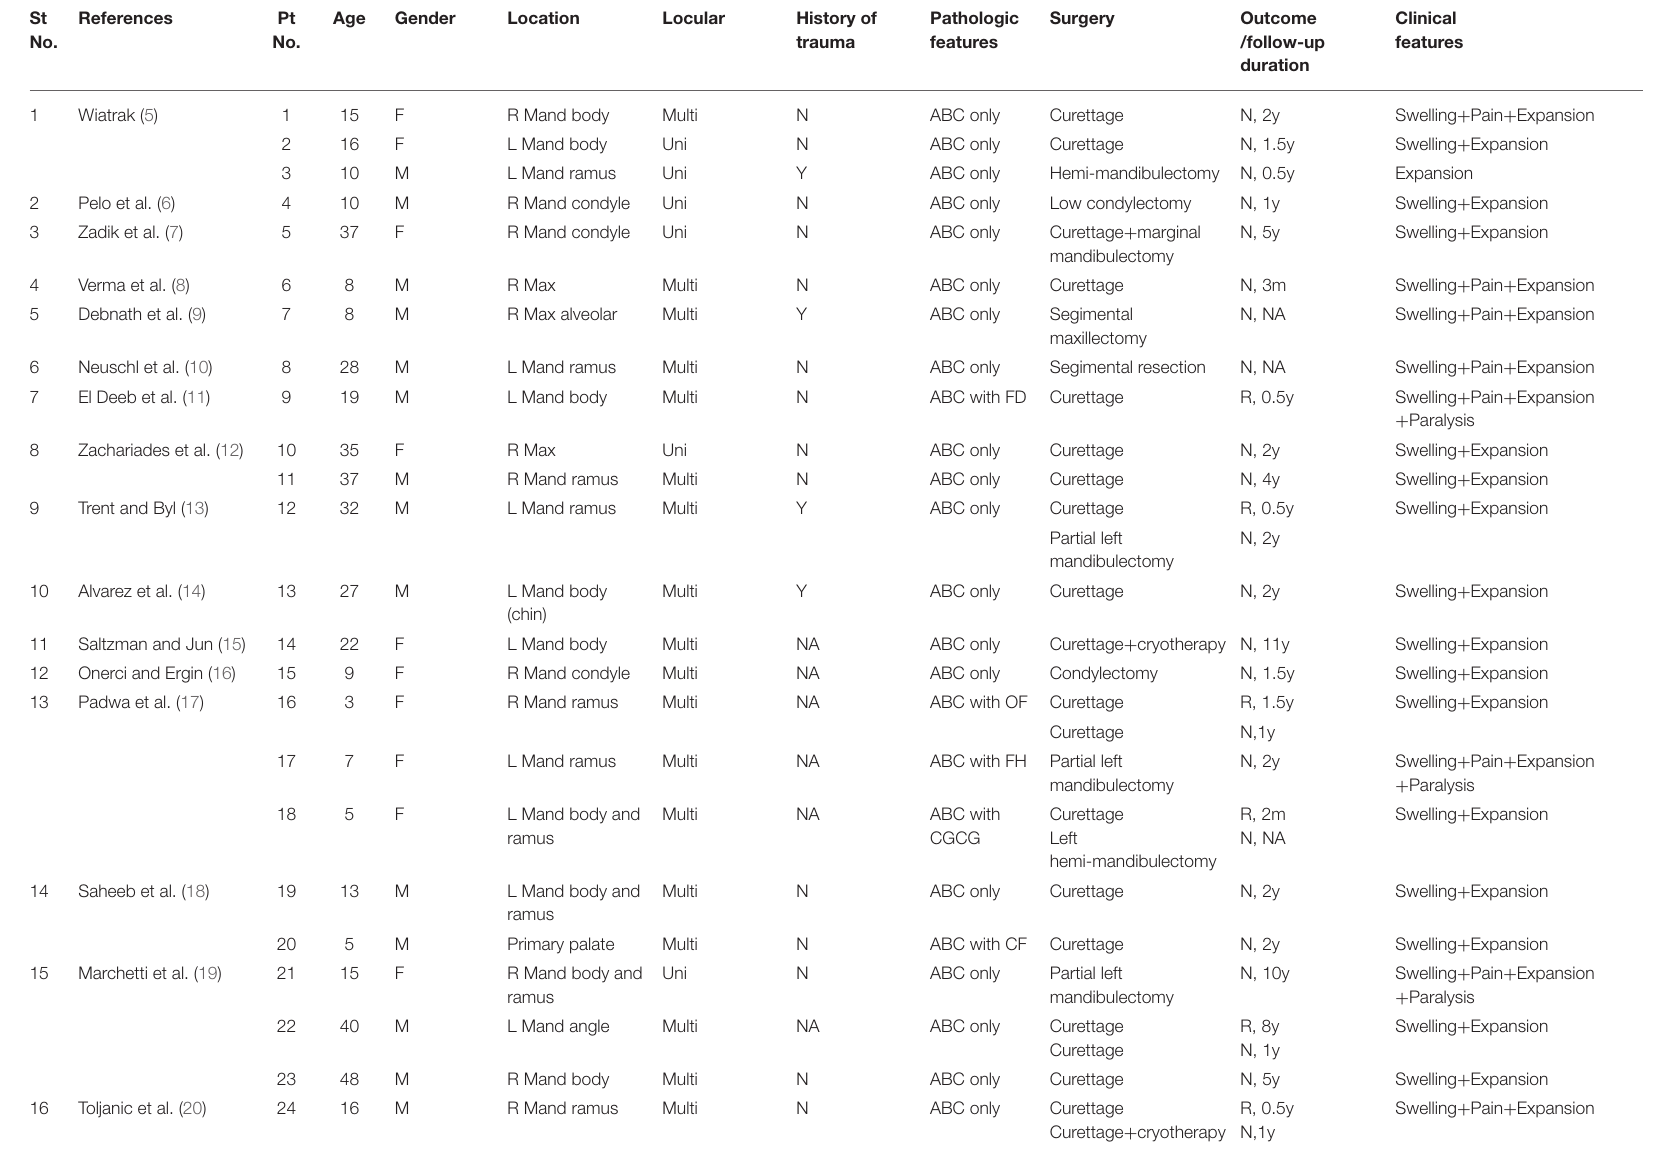
TABLE 1 | Summary OF clinicoradiographic and histopathologic features of 31 studies of jaw aneurysmal bone